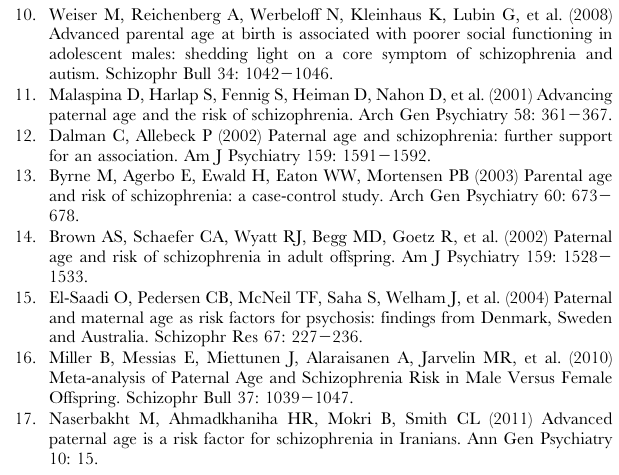
Table S1 Terms involving paternal age at birth in linear and linear mixed-effects models for endophenotype